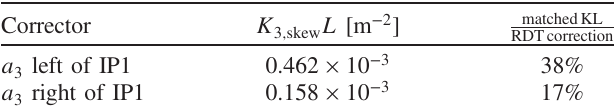
TABLE IV. Integrated corrector strengths required to match the linear variation of feed-down to the horizontal tune in IR1 (while leaving feed-down to Q y unaffected). This represents the a 3 contribution missing from the magnetic model of IR1. The integrated strength required for the matching are also given as a percentage of the corrections calculated from the magnetic measurements via minimization of the relevant RDTs.